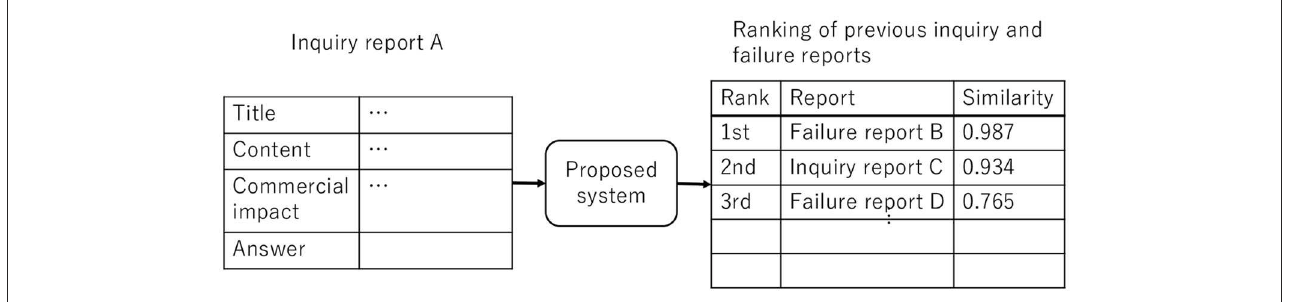
FIGURE6 Inputs and outputs of the proposed system.